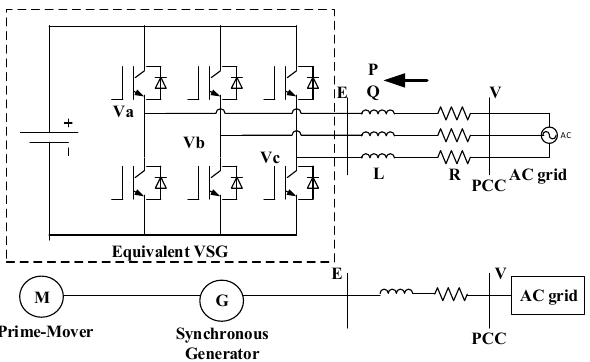
Figure 2. Virtual synchronous generation (VSG)-based system.